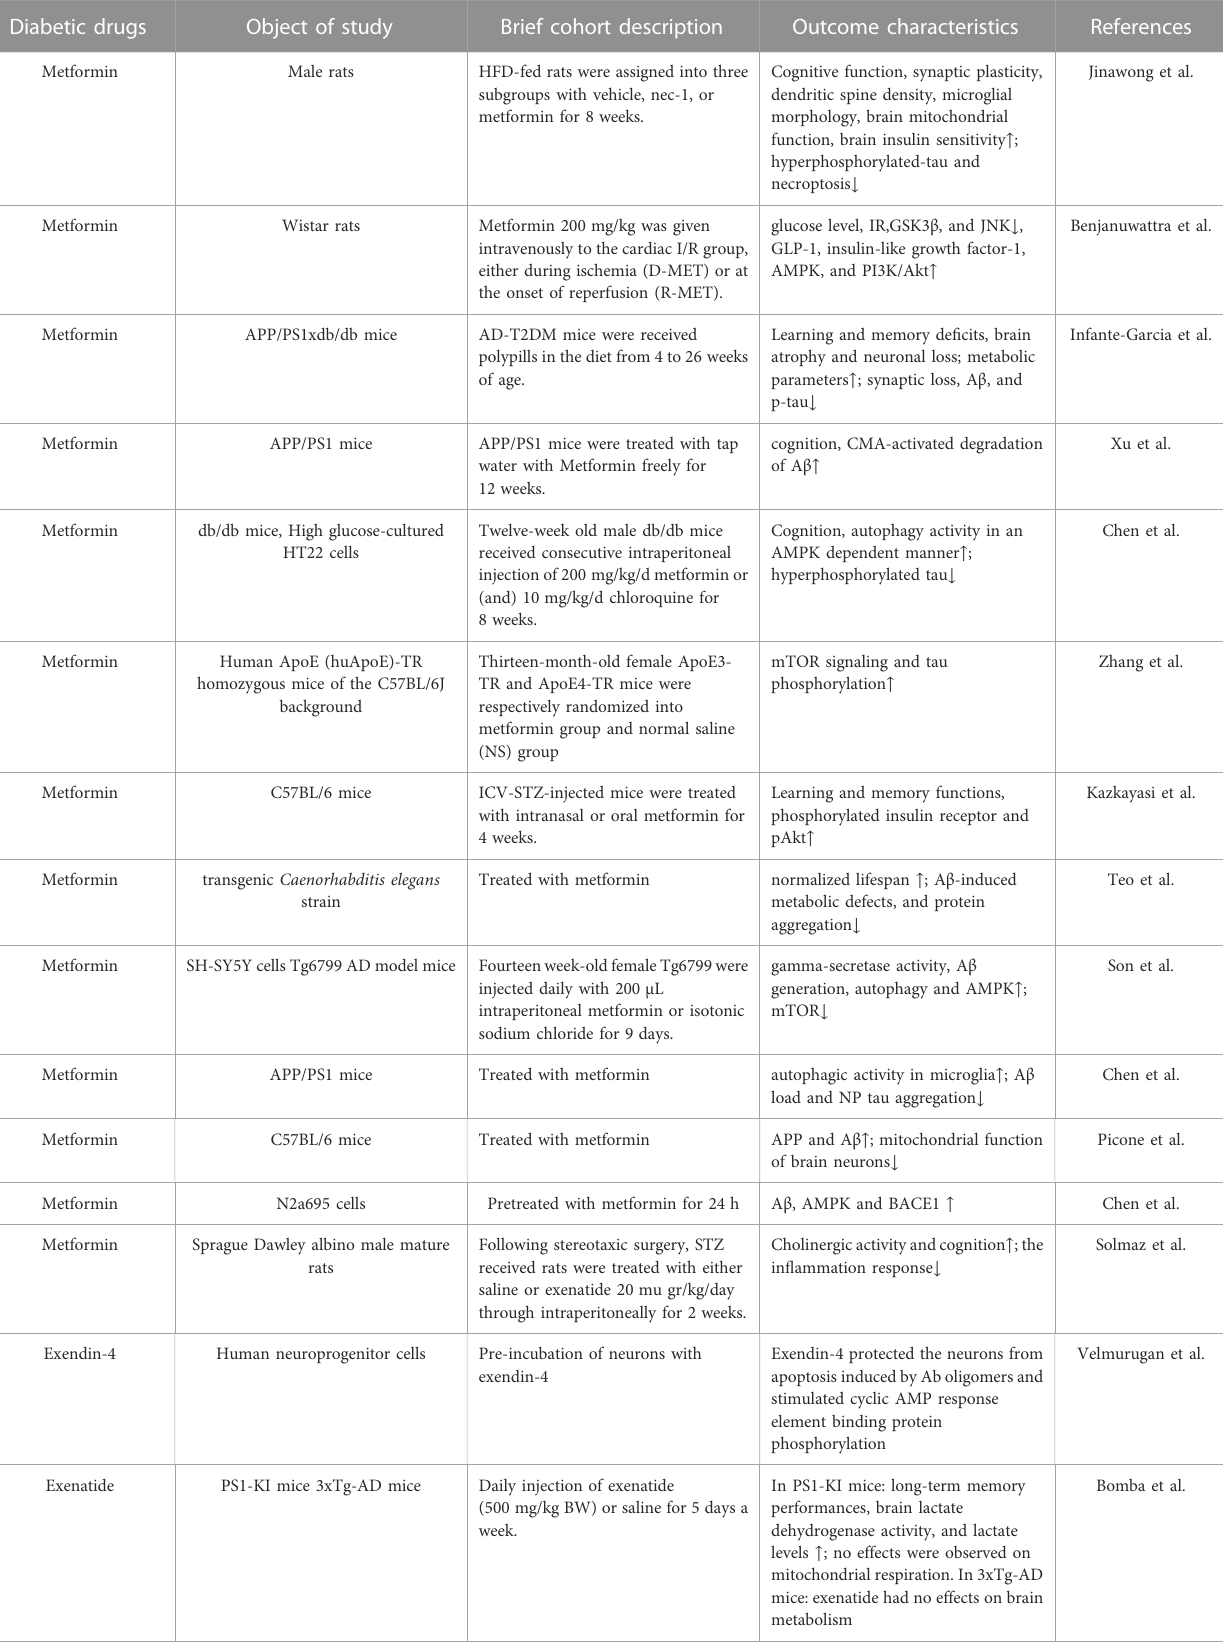
TABLE 1 Overview of animal studies of diabetic drugs in treatment of